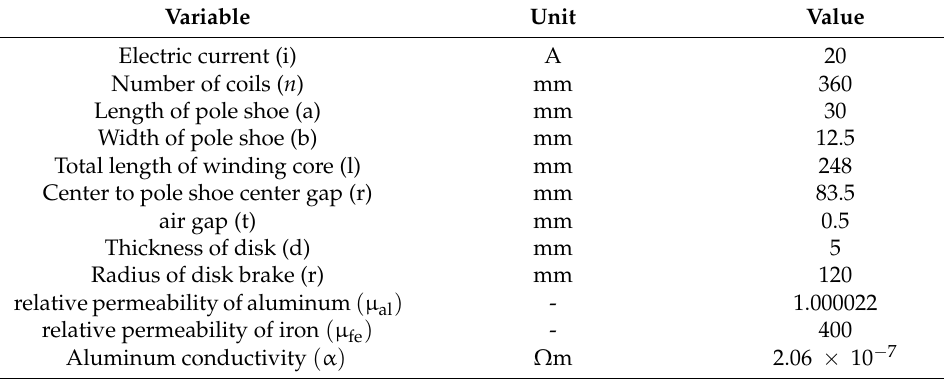
Table 2. Properties of the simulation process carried out.